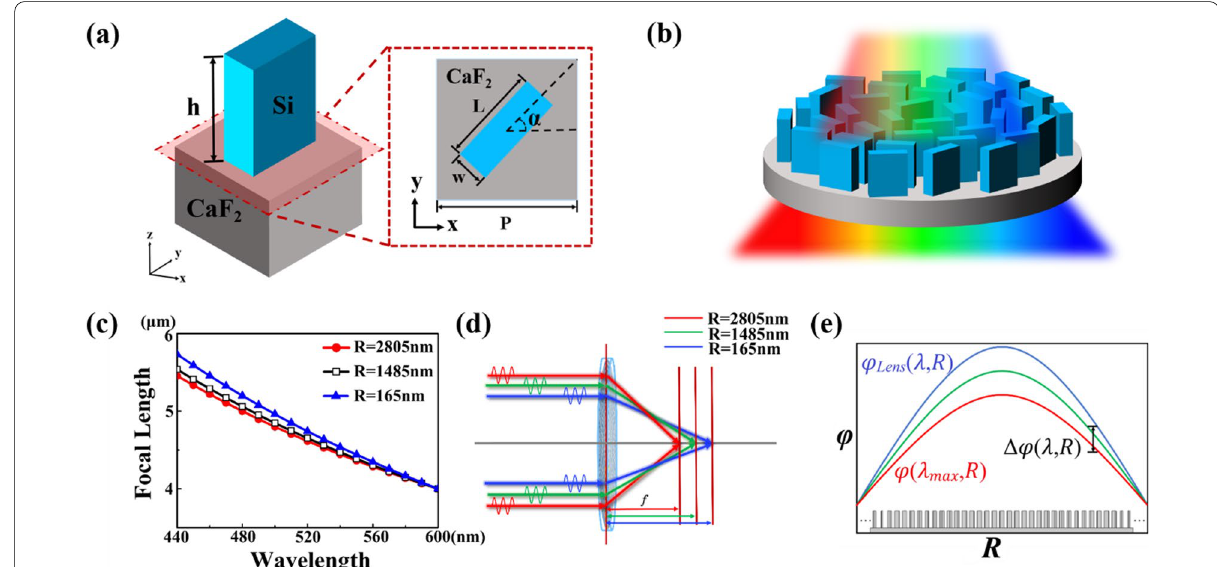
Fig. 1 a Schematic diagram of the structural unit made of Si and CaF 2 substrate. b Schematic diagram of the metalens. c The relationship between the focal length and the wavelength of a lens with a fixed phase distribution. d Causes of chromatic aberration: different incident positions of light lead to different focusing positions after passing through the lens. e Principle of fixed phase and remaining phase of achromatic